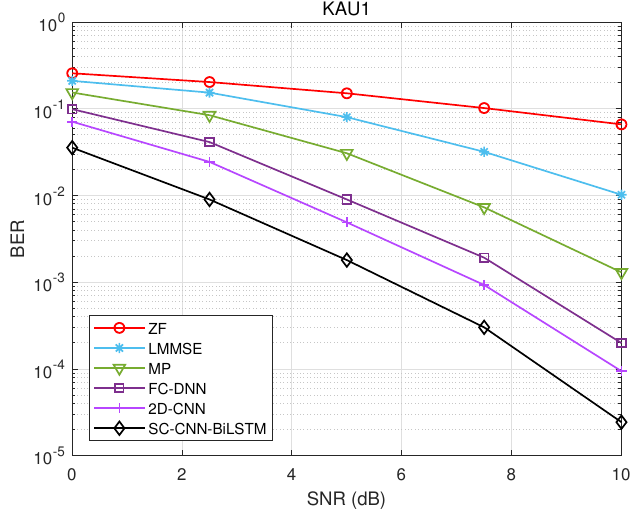
Figure 12. BER performance comparison for KAU1